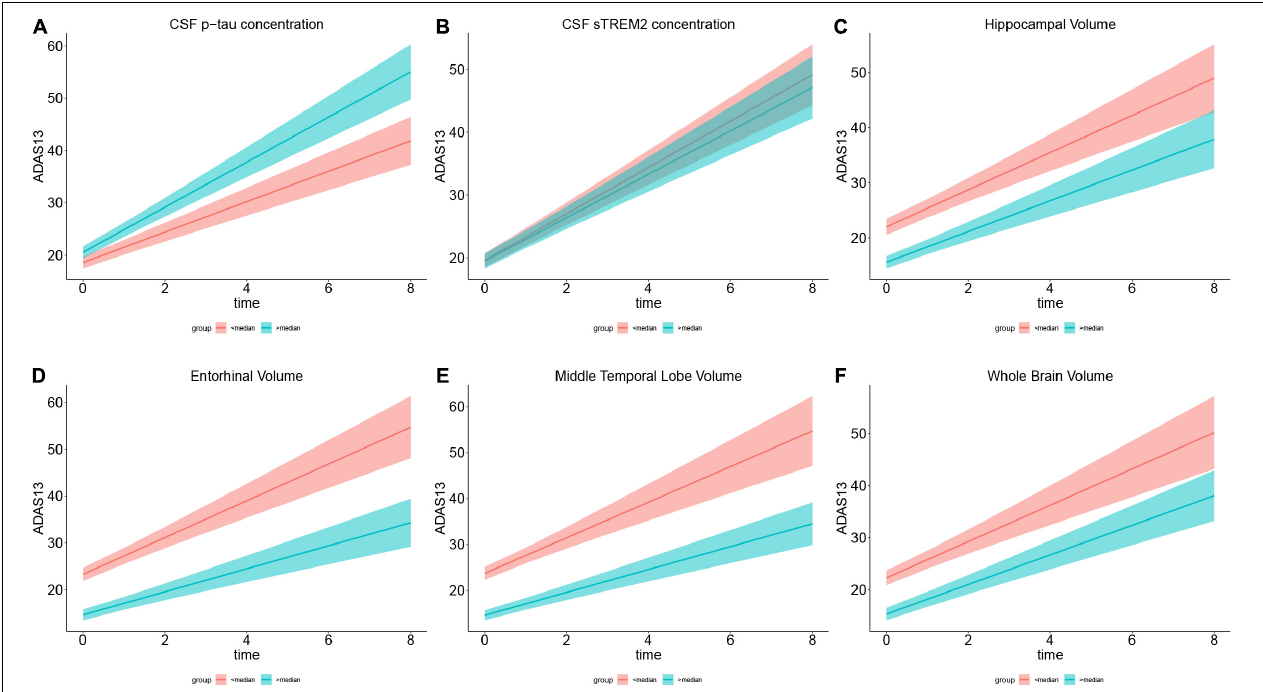
FIGURE 3 | Role of each biomarker in cognitive change measured by ADAS13. (A–F) Show the annual ADAS13 change in cognitive impairment population with A β -positive. For directly illustration, each plot compares ADAS scores between the subgroup who scored below the median (in red) and the subgroup who scored above the median (in green) on the variable in the plot title. (A) Shows higher CSF p-tau concentration has faster cognitive decline in 8-year follow-up. (B) Illustrates higher CSF soluble TREM2 concentration is associated with slower cognitive change. (C–F) Show larger specific brain region volume (including hippocampal, entorhinal, and middle temporal and whole brain) is associated with slower cognitive decline. Brain volumes are segmented from 3.0 T structural MRI. TABLE 5 | Statistical analysis of linear mixed-effect regression for CSF sTREM2 and CSF progranulin concentration in amyloid positive (A + ) groups alone or in combination. CSF sTREM2